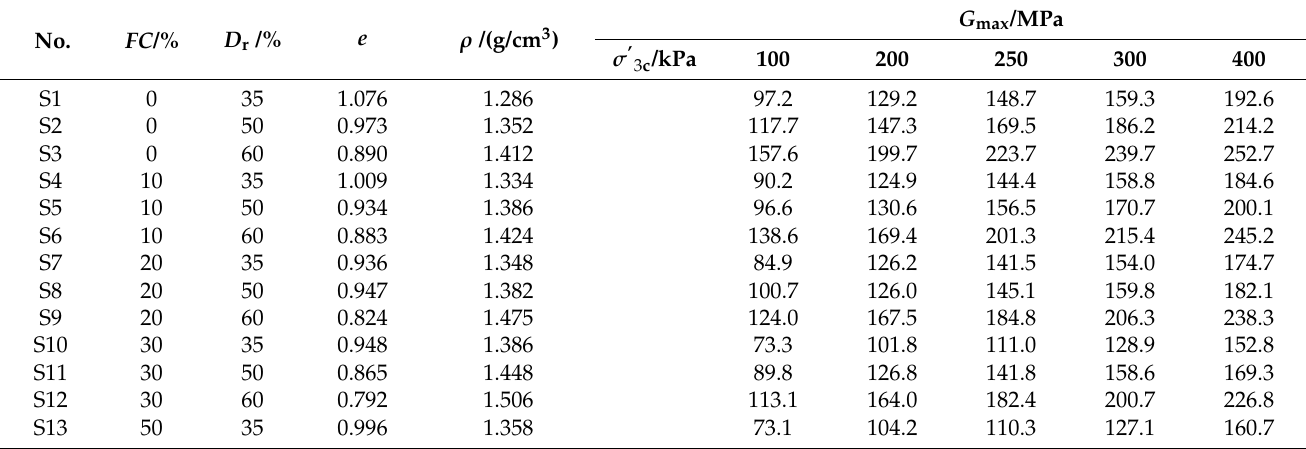
Table 2. The detailed test scheme of the bender element